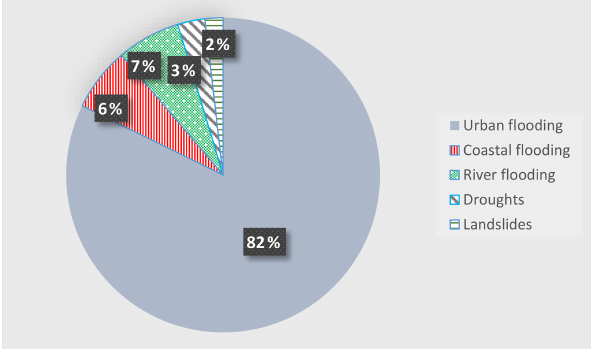
Figure 6. Percentage of published articles that have been stud- ied on nature-based solutions (NBSs) for different types of hydro- meteorological